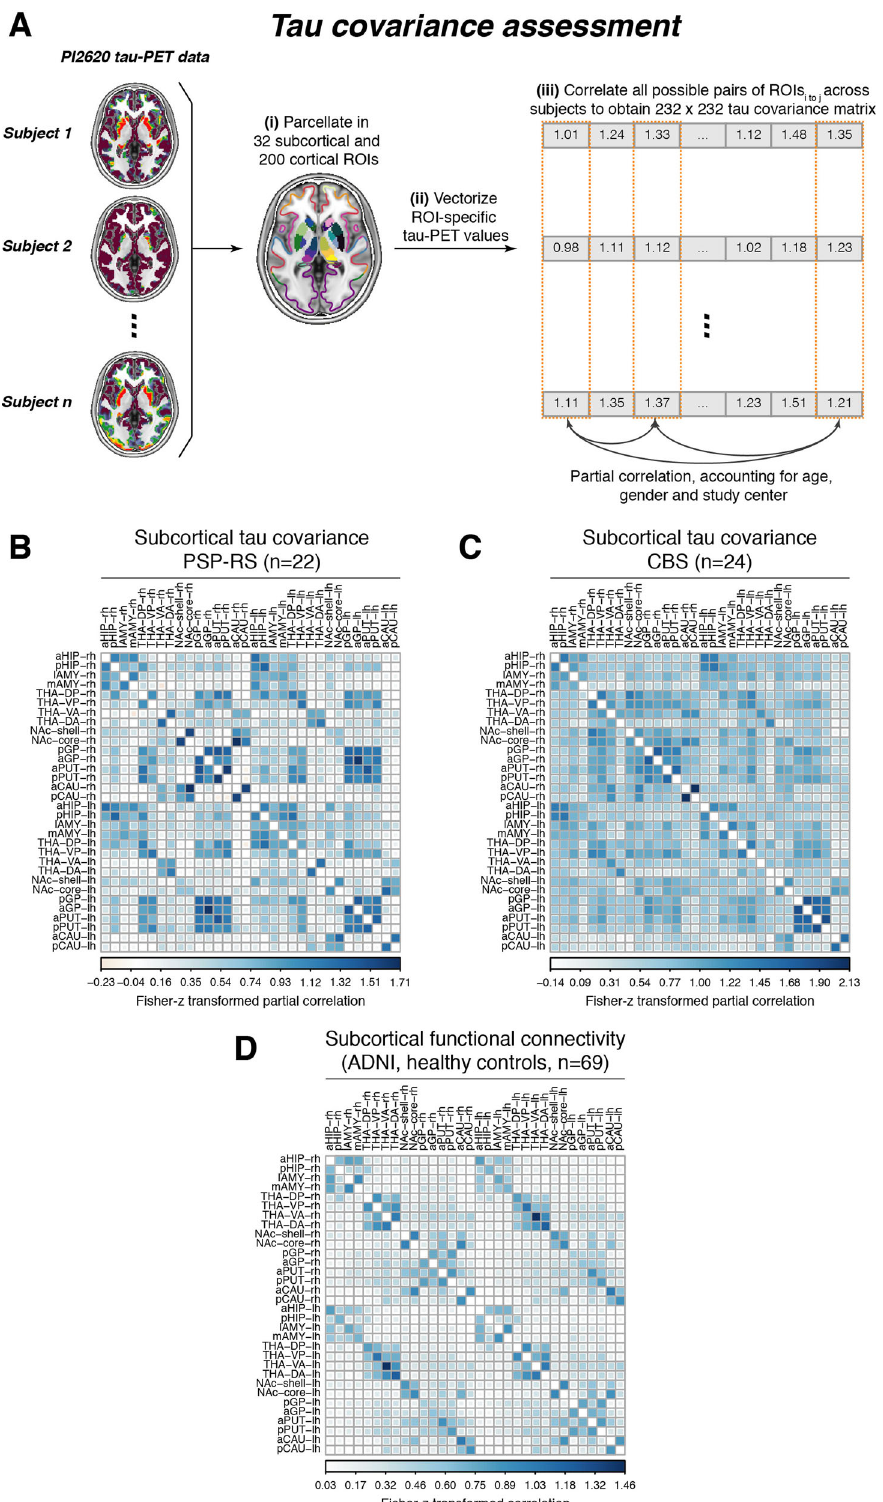
Fig. 3 Assessment of tau covariance. Flow-chart illustrating the assessment of tau covariance ( A ). Subject-level tau-PET data were parcellated into 200 cortical and 32 subcortical ROIs (i), mean tau-PET was extracted for each region of interest (ROI), vectorized to 232-element vectors and concatenated across subjects (ii). Fisher-z transformed partial correlations between inter-regional tau-PET SUVRs were determined for each group (i.e., progressive supranuclear palsy — Richardson syndrome [PSP-RS] and cortico-basal syndrome [CBS]), accounting for age, sex, and study site (iii). The resulting tau covariance matrices for the subcortical brain parcellation which was used for primary analyses is shown for PSP-RS ( B ) and CBS ( C ) patients. For the same ROIs, group-average functional connectivity was computed based on resting-state fMRI of 69 cognitively normal, amyloid and tau negative ADNI participants ( D ). Source data are provided as a Source Data fi